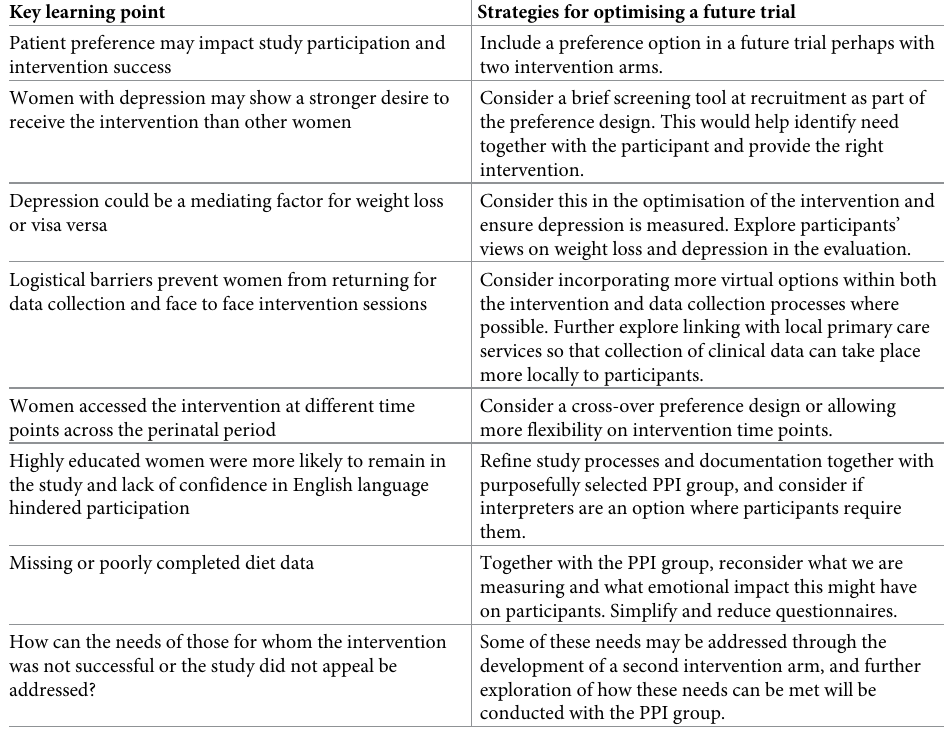
Table 7. Key learning points and strategies for optimising a future